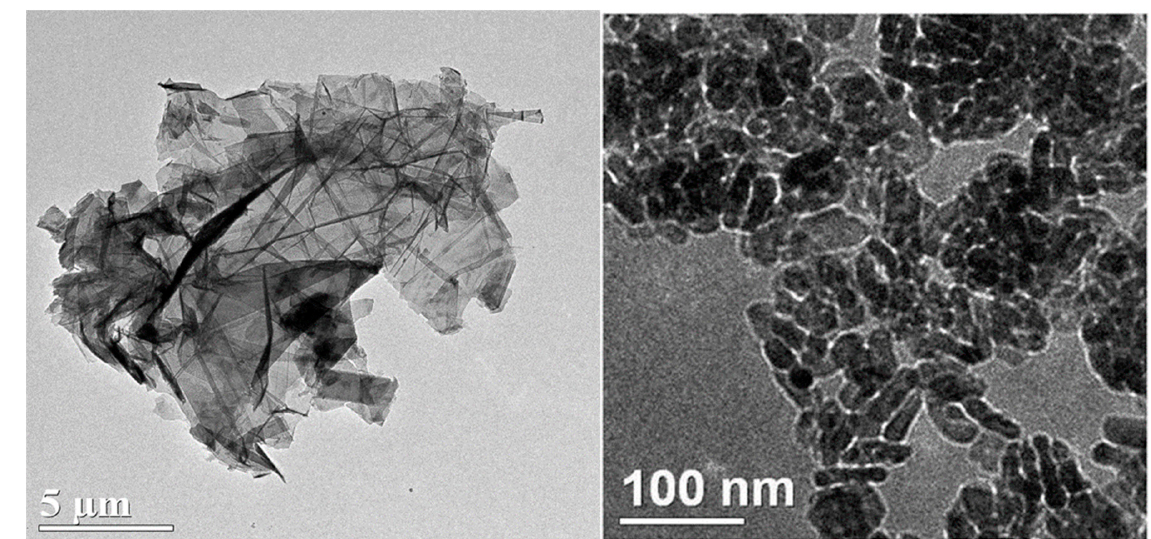
Figure 5 . Sample photographs of: ( a ) Graphene nanoplatelets; ( b ) MgO NPs .